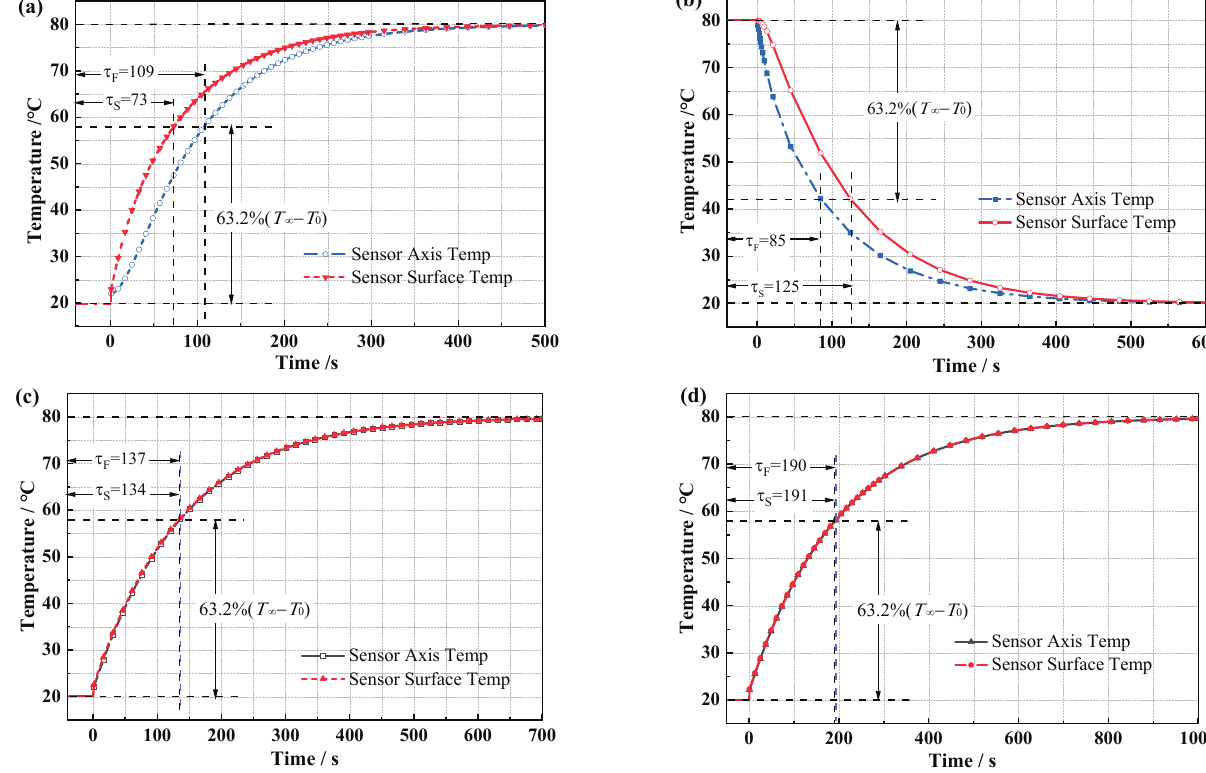
Figure 8. ( a ) Time response of positive temperature jump for the air-medium FBG temperature sensor’s surface and axis. ( b ) Time response of negative temperature jump for the air-medium FBG temperature sensor’s surface and axis. ( c ) Time response of positive temperature jump for the grease-medium FBG temperature sensor’s surface and axis. ( d ) Time response of positive temperature jump for the copper-medium FBG temperature sensor’s surface and